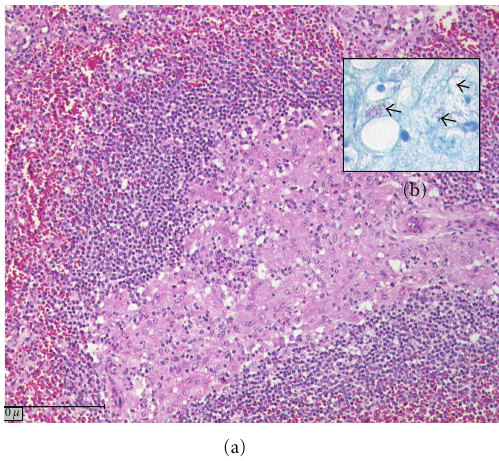
Figure 2: Histologic appearance of spleen sections stained with hematoxylin and eosin (a) and with Ziehl-Neelsen (b) showing BCG infiltration